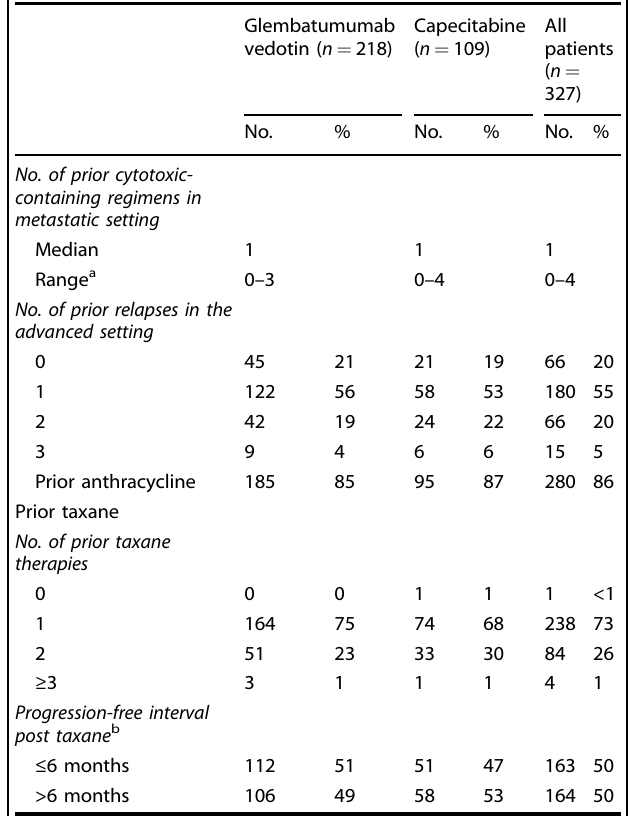
Table 1. Pretreatment patient characteristics.